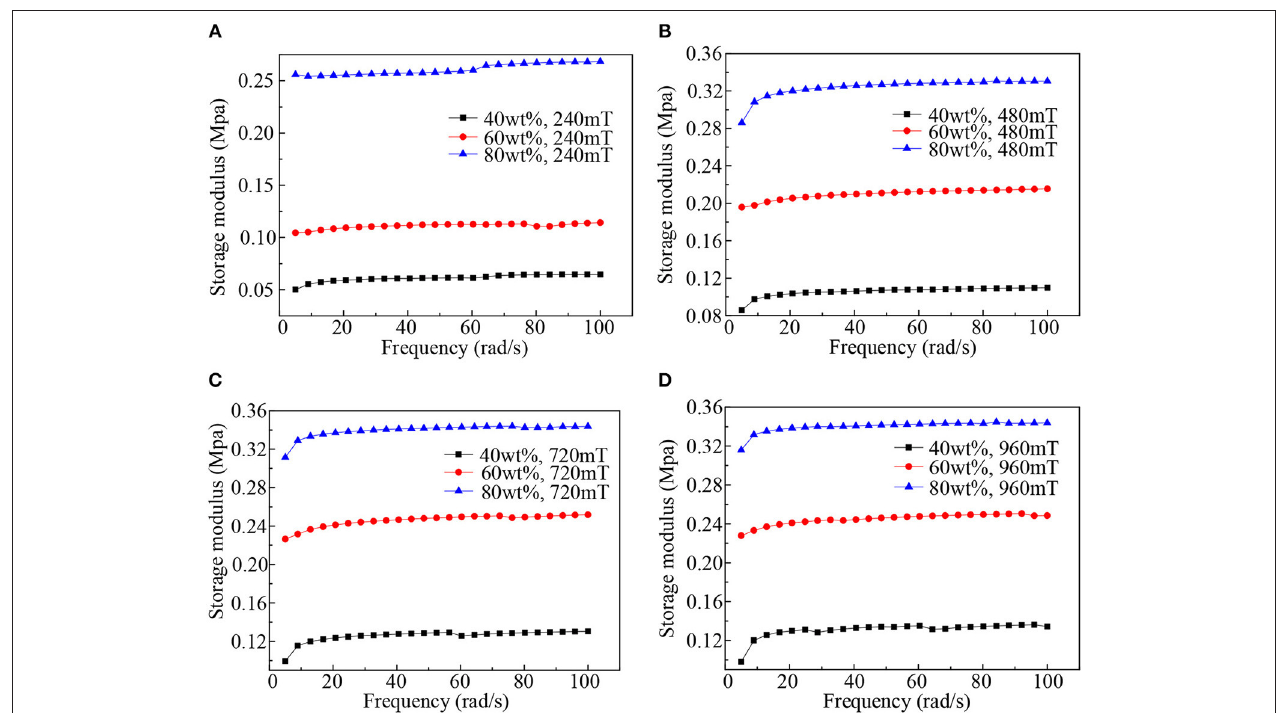
FIGURE 9 | Storage modulus as a function of angular frequency. ( A : B = 240mT; B : B = 480mT; C : B = 720mT; D : B = 960mT).